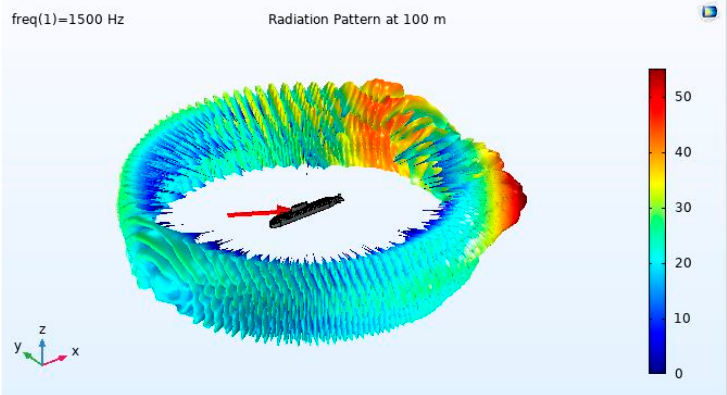
Figure 5. The pattern of radiation one hundred meters distant from the submarine.